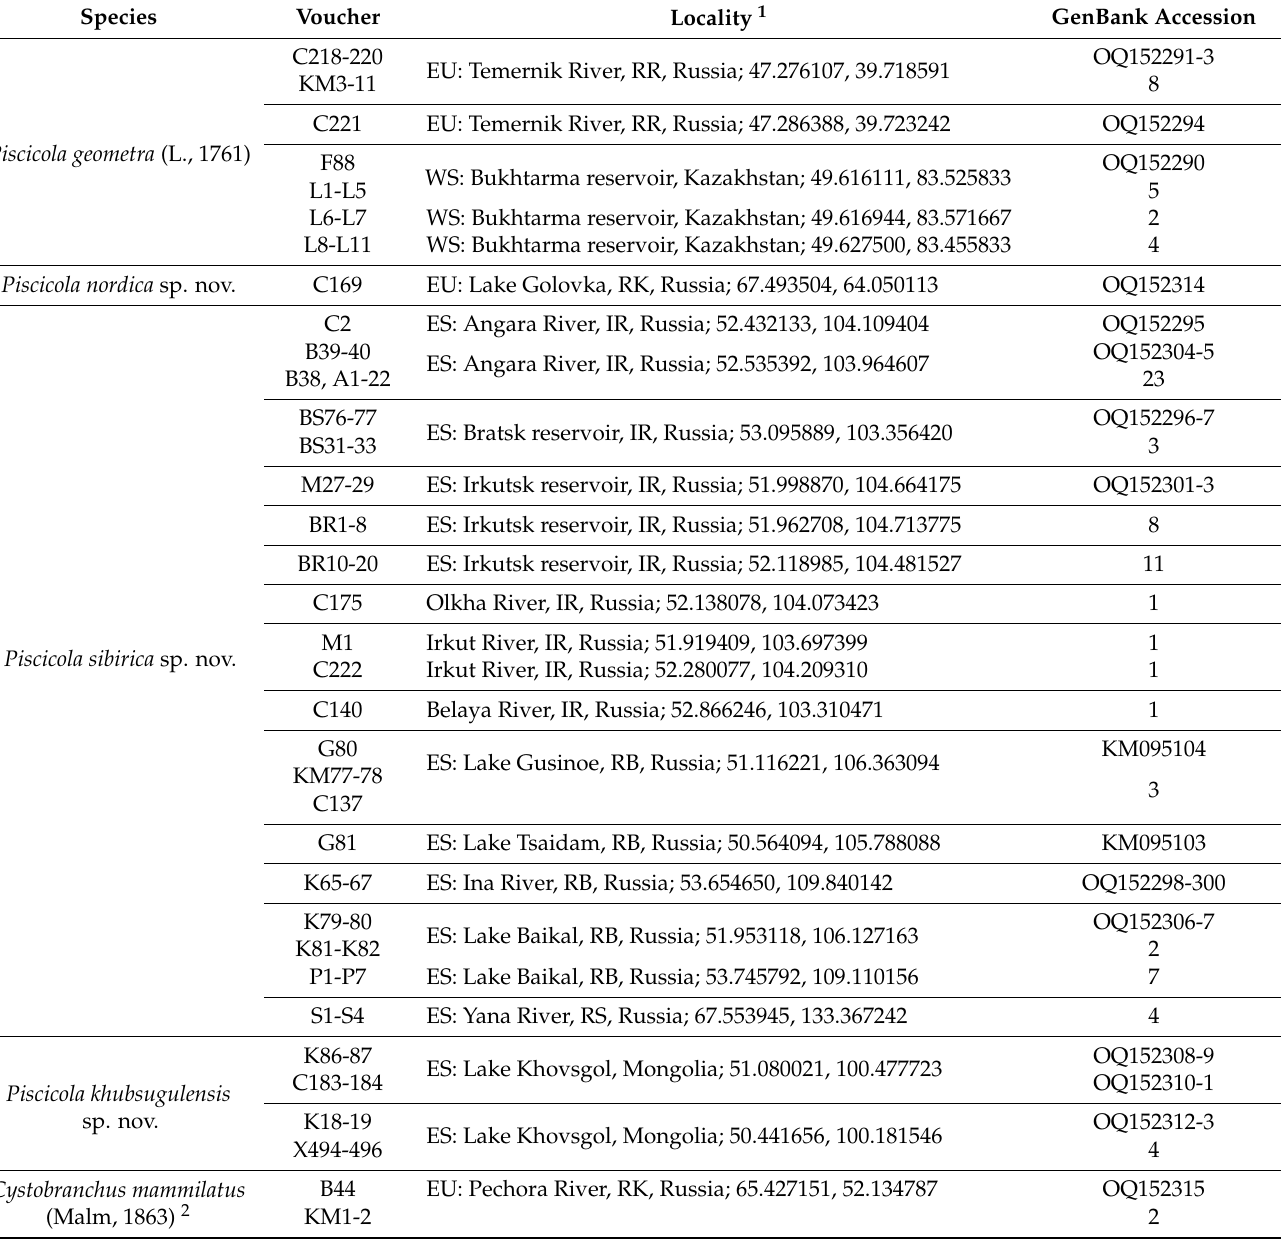
Table 1. List of the Piscicola spp. specimens used in this study with indication of voucher, sampling location and GenBank accession number of newly sequenced